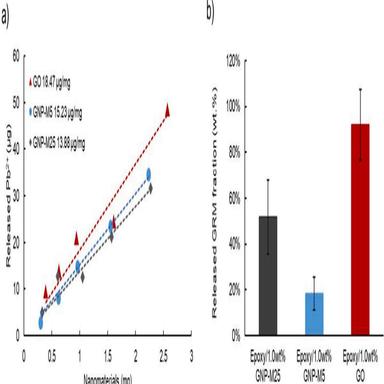
a) Lead release capacities of lead-labeled GRMs (GNP-M5, GNP-M25 and GO); points represent measured values and lines represent linear fits of the measured lead release capacities, b) Released GRM fraction in abraded particles and standard deviation from threefold measurements (n = 3) from Epoxy/1.0 wt% GO, Epoxy/ 1.0 wt% GNP-M5 and Epoxy/1.0 wt% GNP-M25. For comparison, we show data from Epoxy/1.0 wt% GNP-M25 and Epoxy/1.0 wt% GO, that was also used in our previous study (Netkueakul et al. 2020).